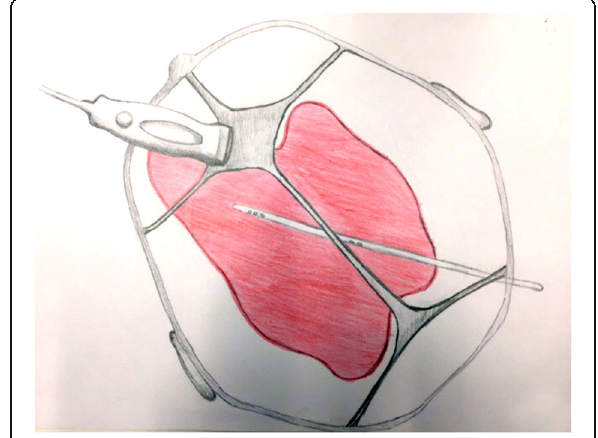
Fig. 2 Illustration of VP shunt revision under transfontanellar ultrasound